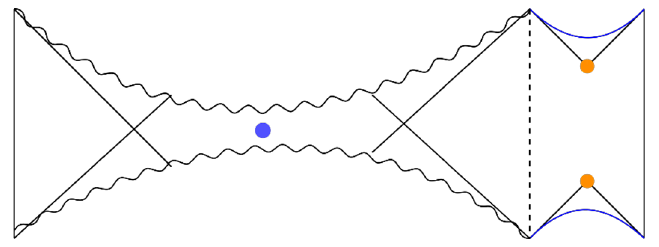
Figure 2 . The Penrose diagram of the backreacted black hole. As we increase the CFT tempera- ture, the black hole interior region gets longer. The blue dot represents the apparent horizon of the black hole, which differs from the event horizons. The orange dots are the cosmological apparent horizons, which are shown as overlapping the cosmological event horizons, but in general there is a slight difference between their positions. In the high temperature limit, they coincide at the diagram